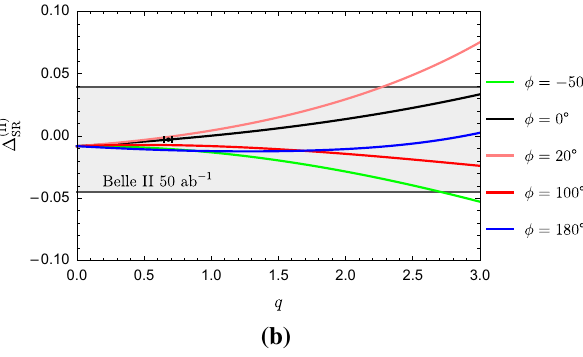
Fig. 16 The sum rules introduced in Eqs. (85) and (89) as functions of q for different values of the CP-violating phase φ . The grey horizontal band illustrates the ultimate experimental precision at Belle II, assum-